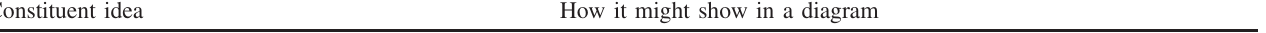
TABLE IV. Checklist for assessing the extent to which an energy diagram shows constituent ideas of the NGSS model of energy. Constituent idea How it might show in a diagram Conservation Quantities or units of energy are pictured explicitly and same quantity of energy or number of energy units are visible throughout scenario